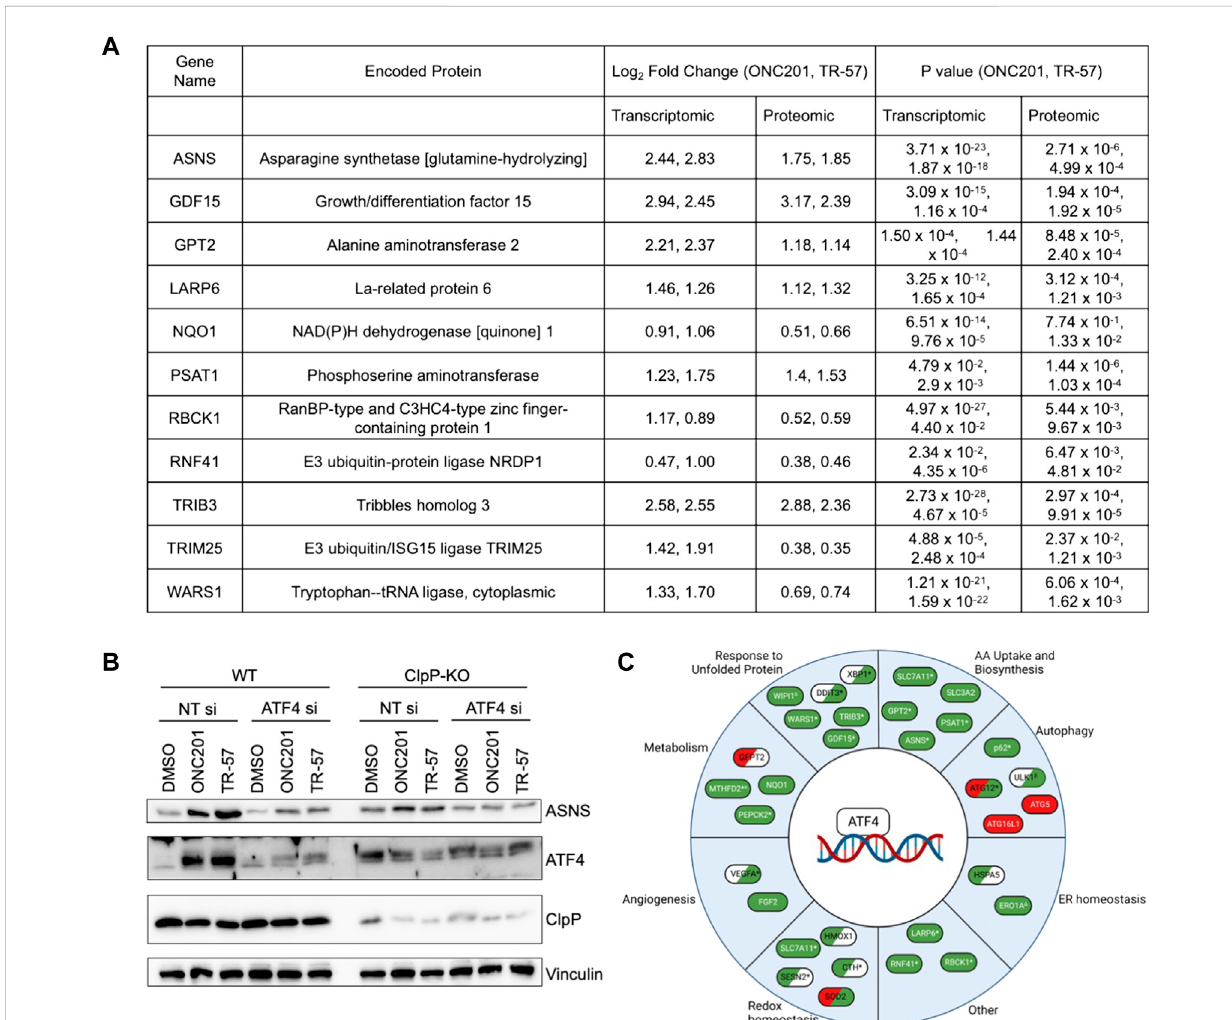
FIGURE 5 Pharmacological ClpP activation leads to ATF4 induction and increase in ATF4 target genes in TNBC cells. (A) Table of selected ATF4-dependent genes/proteins and their measured Log 2 (Fold Change) and p -value fromproteomics and transcriptomicsdata fromWT SUM159cells treatedwith 10 μ M ONC201 and 150 nM TR-57 for 24 h. (B) Immunoblot of SUM159 cells treated with 0.1% DMSO, 10 μ M ONC201, or 150 nM TR-57 for 24 h. Cells were either treated with a non-targeting siRNA or an ATF4 siRNA. Representative of N = 2. (C) Schematic of ATF4 target genes and their involvement in diversecellularprocesses.Green:transcriptsandproteinwereupregulatedinWTSUM159cellstreatedwitheitherONC201orTR-57.Red:transcriptsand protein were downregulated in WT SUM159 cells treated with either ONC201 or TR-57. White: not detected in our datasets. Items in two colors indicate direction of change in proteomics (left) and transcriptomics (right). *At least one dataset is signi fi cant ( p -value < 0.05); α TR-57 treated SUM159 cells showed decreased proteomic values; β TR-57 treated SUM159 cells showed decreased transcriptomic values; Δ TR-57 treated SUM159 cells showed decreased proteomic and transcriptomic values; δ Not detected in TR-57 treated SUM159 cells